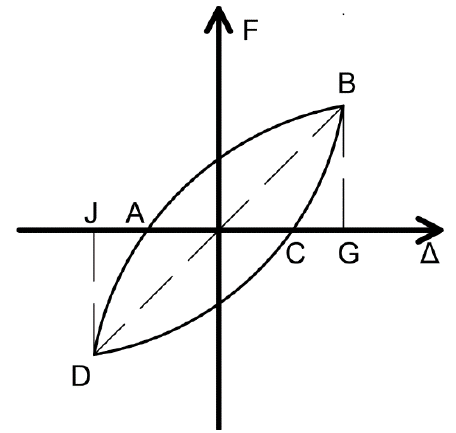
Figure 13. Definition of β .